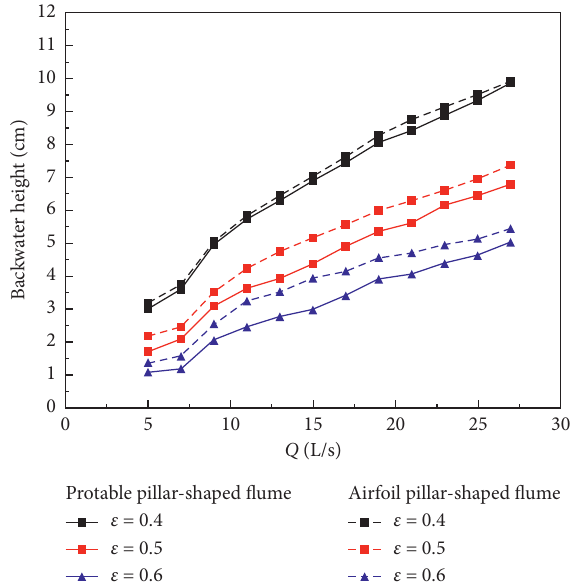
Figure 15: The variation of the backwater height of the portable pillar-shaped flume versus discharge